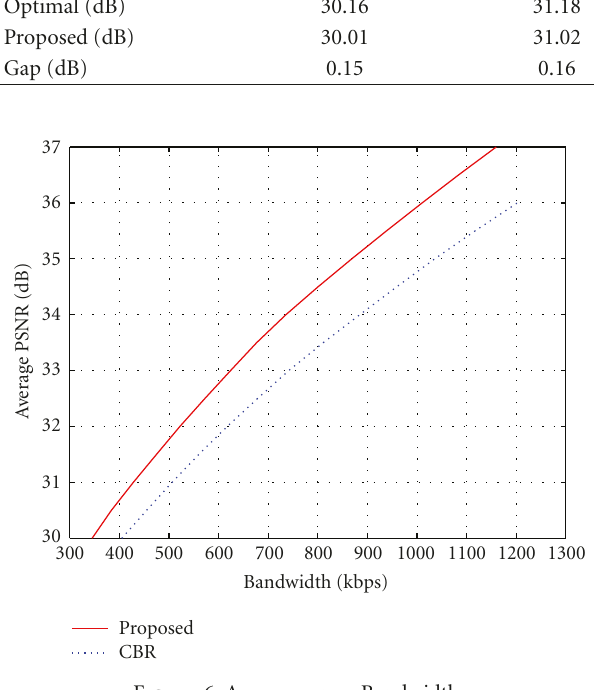
Figure 6: Average versus Bandwidth.